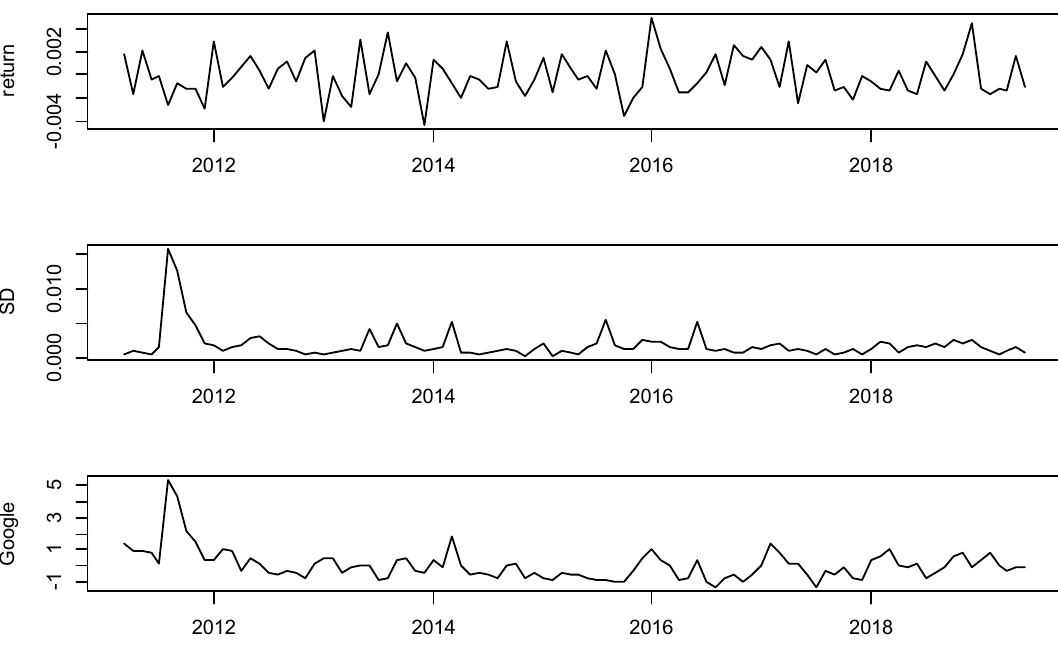
Figure A10. Comparison of monthly series: Excess return, RV and Google search volume, Poland.